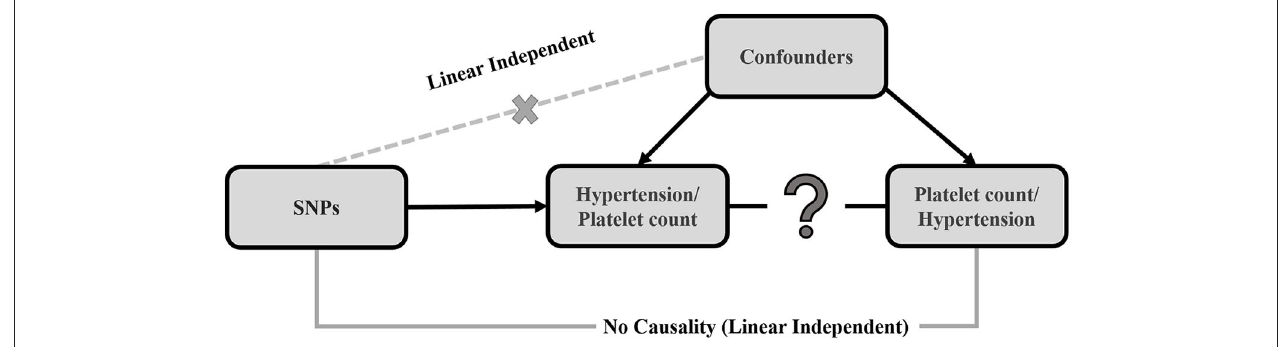
FIGURE 1 | Causal directed acyclic graph, displaying the 3 assumptions of Mendelian randomization. The black arrows show instrumental variable (IV) assumptions. The crossed dotted gray lines depict the violations of the assumptions. The single genetic variant (SNP) that satisfies the IV assumption is G j . The effect of the single genetic variant (SNP) on the exposure (X) is β xj and the causal effect of the exposure (X) on the outcome (Y) is 2 .